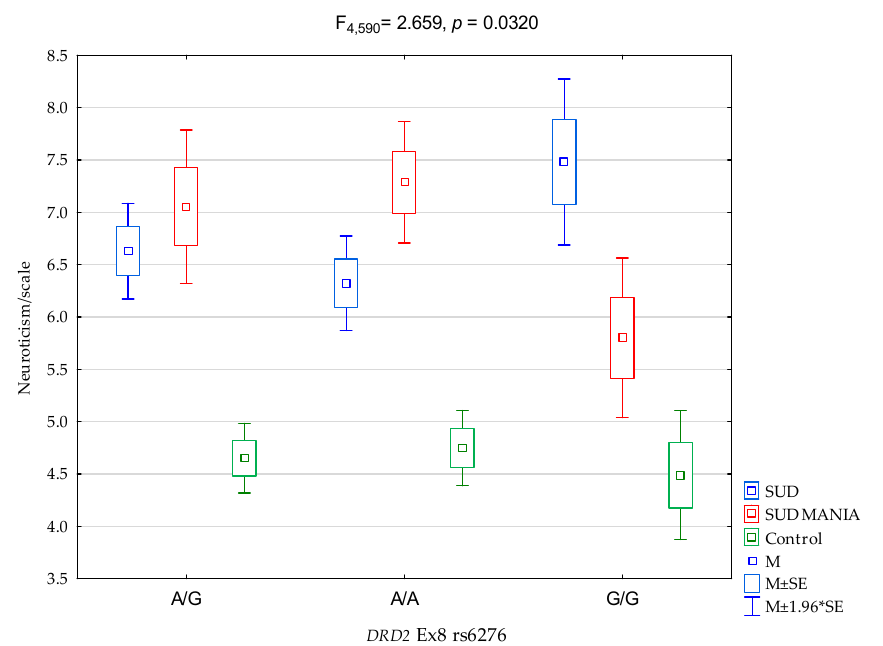
Figure 2. The relationship between patients diagnosed with polysubstance use disorder comorbid with a maniacal syndrome (SUD MANIA)/control and DRD2 rs6276 and the NEO FFI Neuroticism scale. Table 6. Post hoc analysis of dependences between patients diagnosed with polysubstance use dis- order comorbid with a maniacal syndrome (SUD MANIA)/control and DRD2 rs6276 and NEO FFI Neuroticism scale.